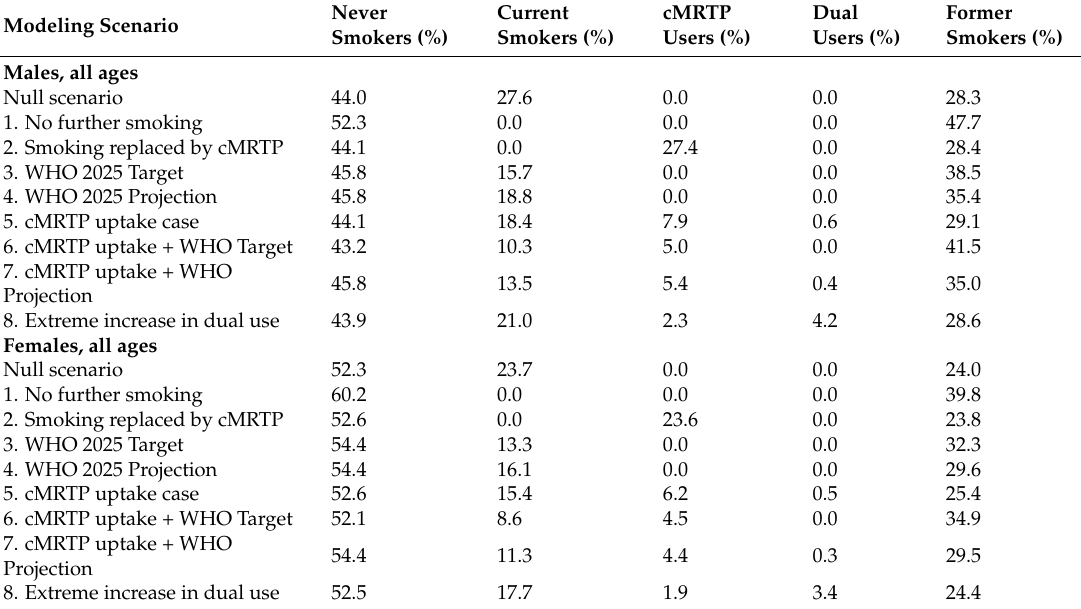
Table 1. Summary of smoking prevalence after the 20-year period for the null and alternative scenarios. Modeling Scenario